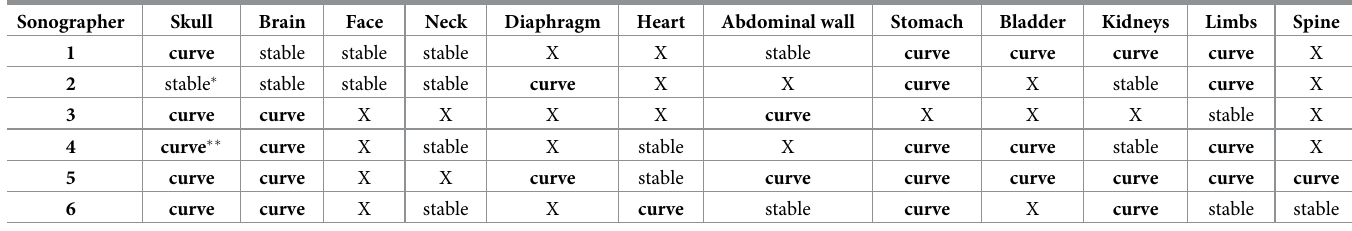
Table 6. Organ-specific CUSUM analysis.